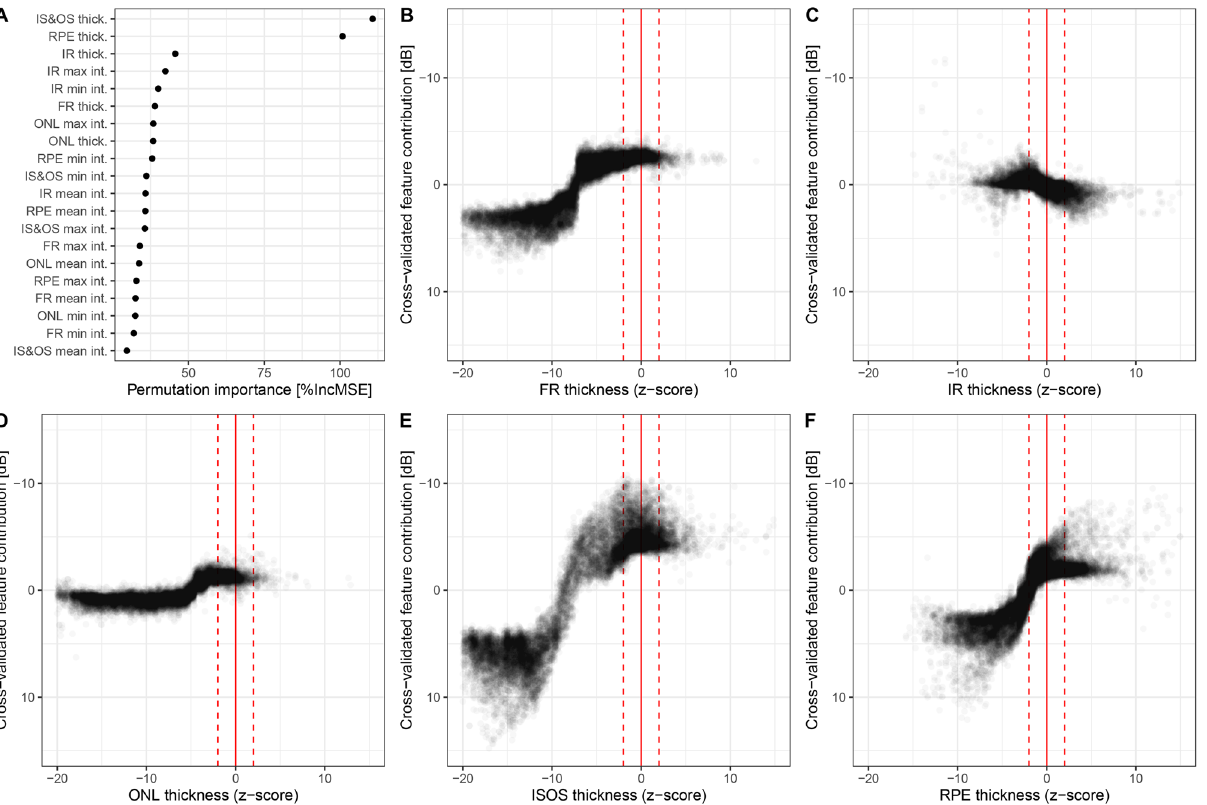
Figure 4. Feature importance. ( A ) The panel shows the permutation feature importance of layer thickness (thick.) as well as mean, maximal (max) and minimal (min) intensity projections (int.) in terms of the percentage of increase in mean squared error (%IncMSE). Overall, the photoreceptor inner and outer segments (IS&OS) thickness and retinal pigment epithelium (RPE) thickness were the two most important features. The permutation feature importance of the other feature sets can be found in Supplementary Fig. S2. ( B – F ) The other panels demonstrate the feature contributions [dB] of the respective retinal layer thickness. The dashed lines show the normal range (− 2 to + 2 normative standard deviations) for the thicknesses. The y-axis for these plots was inverted to ensure that sensitivity loss is plotted downwards. The so-called goodness-of-visualization R 2 metric 25 , which denotes the variance of feature contributions explained by these simple X–Y plots was 0.89 for the full retinal (FR) thickness ( B ), 0.42 for the Inner retinal (IR) thickness ( C ), 0.8 for the outer nuclear layer (ONL) thickness ( D ), 0.92 for IS&OS thickness ( E ), and 0.81 for the RPE thickness ( F